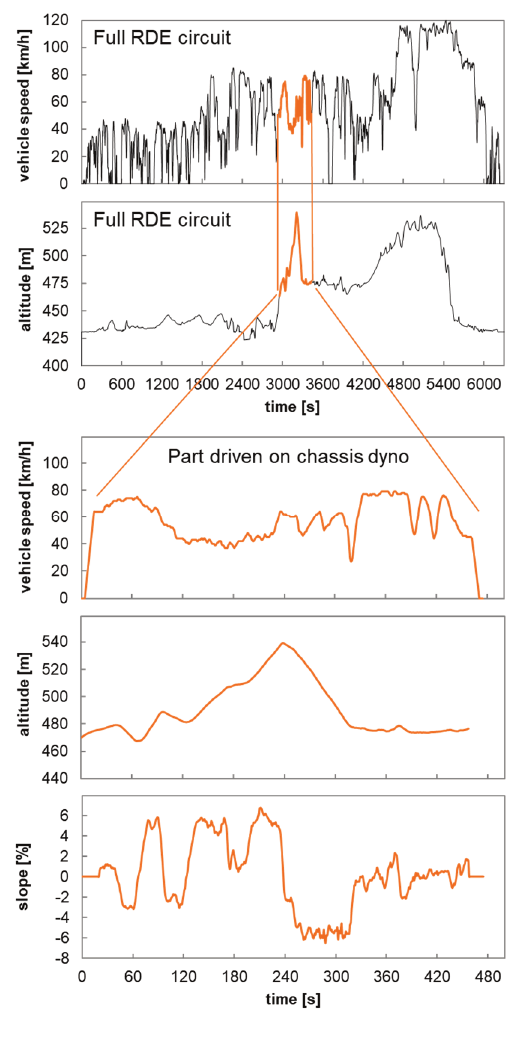
Fig. 14. RDE circuit and part used for chassis dyno measurement; HORI- BA OBS One; Volvo (V1)